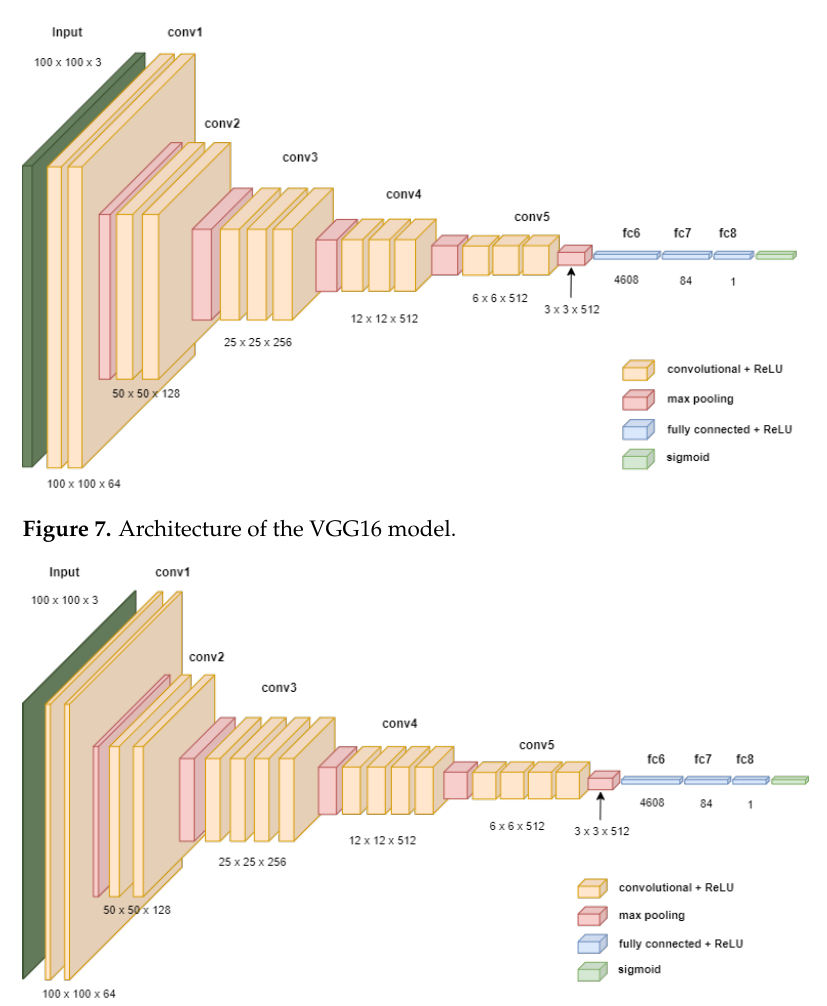
Figure 8. Architecture of the VGG19